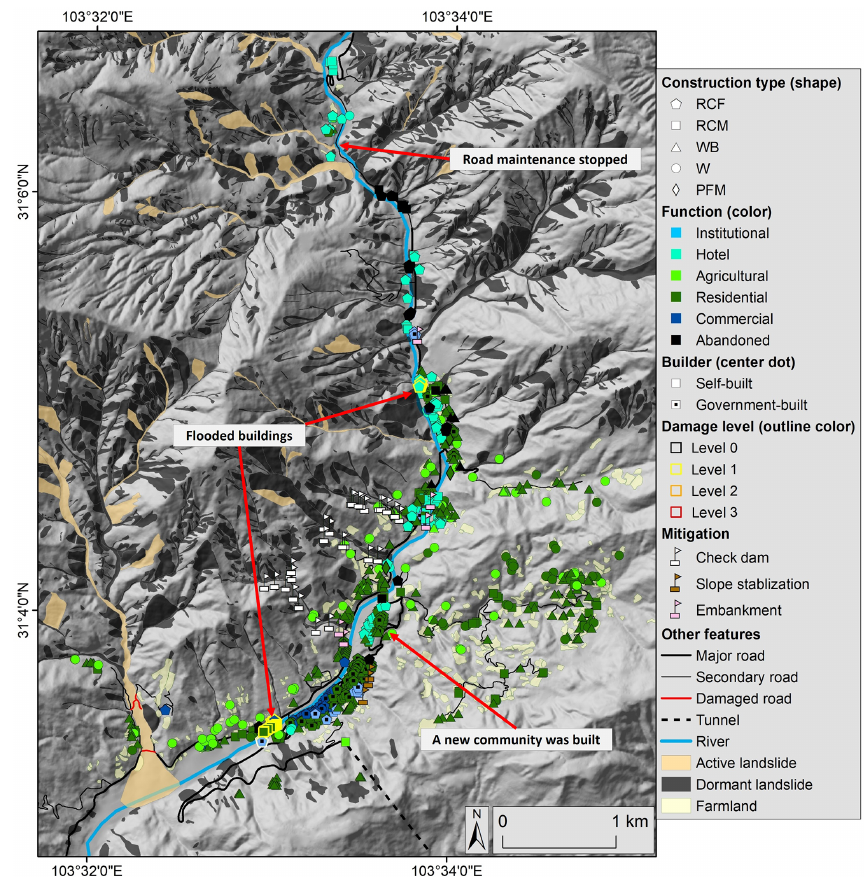
Figure 9. The inventory mapped based on the 2013 Pléiades image, showing the situation shortly after the official announcement of recon- struction completion. A new community that was built to make up the loss caused by the 2010 debris flow and many mitigation measures that were installed are shown. The debris flows caused a rise of the riverbed and led to flooding, the location of which is